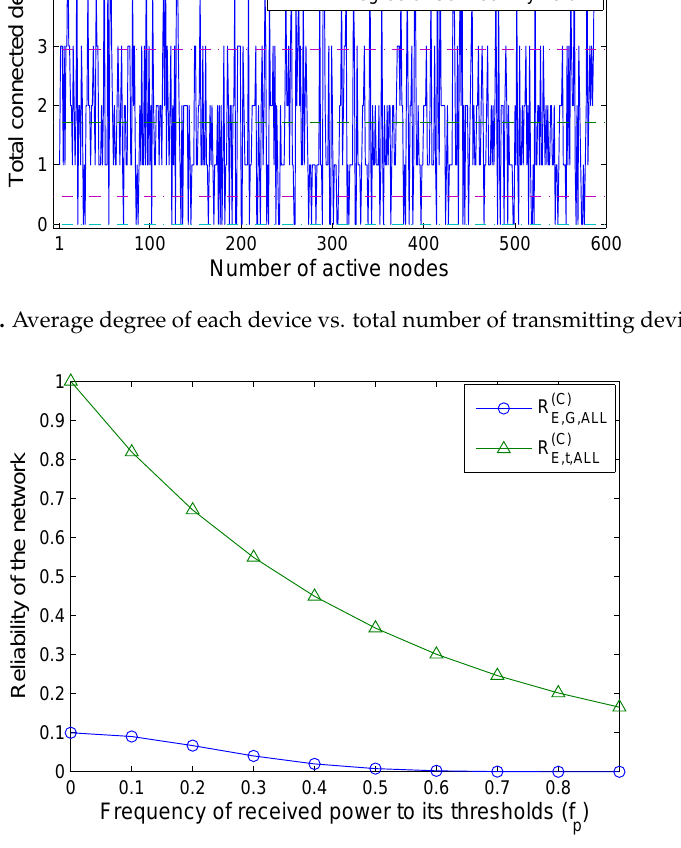
Figure 5. Reliability of the network vs. frequency of received power to the thresholds for